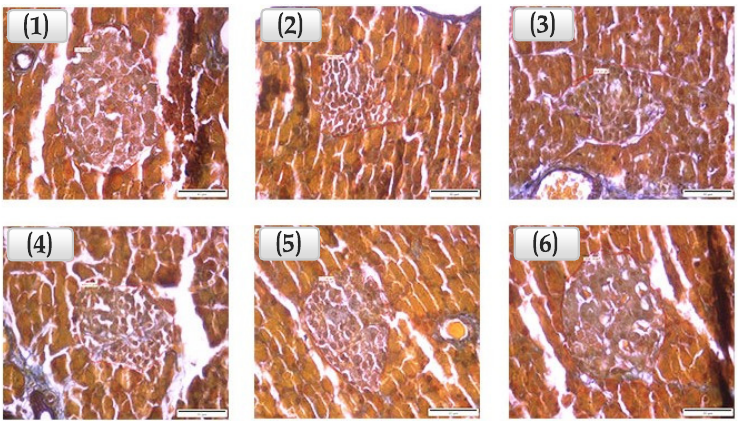
Figure 7. Langerhans islets under 400× magnification power. ( 1 ) NC: langerhans islets are clearly defined in an organized cyto-architecture. Secretory acini, centroacinar cells and excretory ducts appear to be well defined; ( 2 ) DC: Cytotoxic effects of Streptozotocin seem to have caused a distortion in the architecture of the pancreatic tissues. The islets are greatly reduced in size and number and the islet cells appear necrotic with marked vacuolations; ( 3 ) PC: cyto-architecture appears distorted. Langerhans islets are reduced in size and number, with necrotic acinar cells and degenerate islet cells; ( 4 ) TG1: Langerhans Islets appear to be small, with minor vacuolations and cyto-architecture distortion; ( 5 ) TG2: Langerhans Islets appear to be large and defined. Minor vacuolations and cyto-architecture distortion are present. Secretory acini, centroacinar cells and excretory ducts appear to be well defined; ( 6 ) TG3: Islet cells appear to be prominent and large. Edges seem to be well